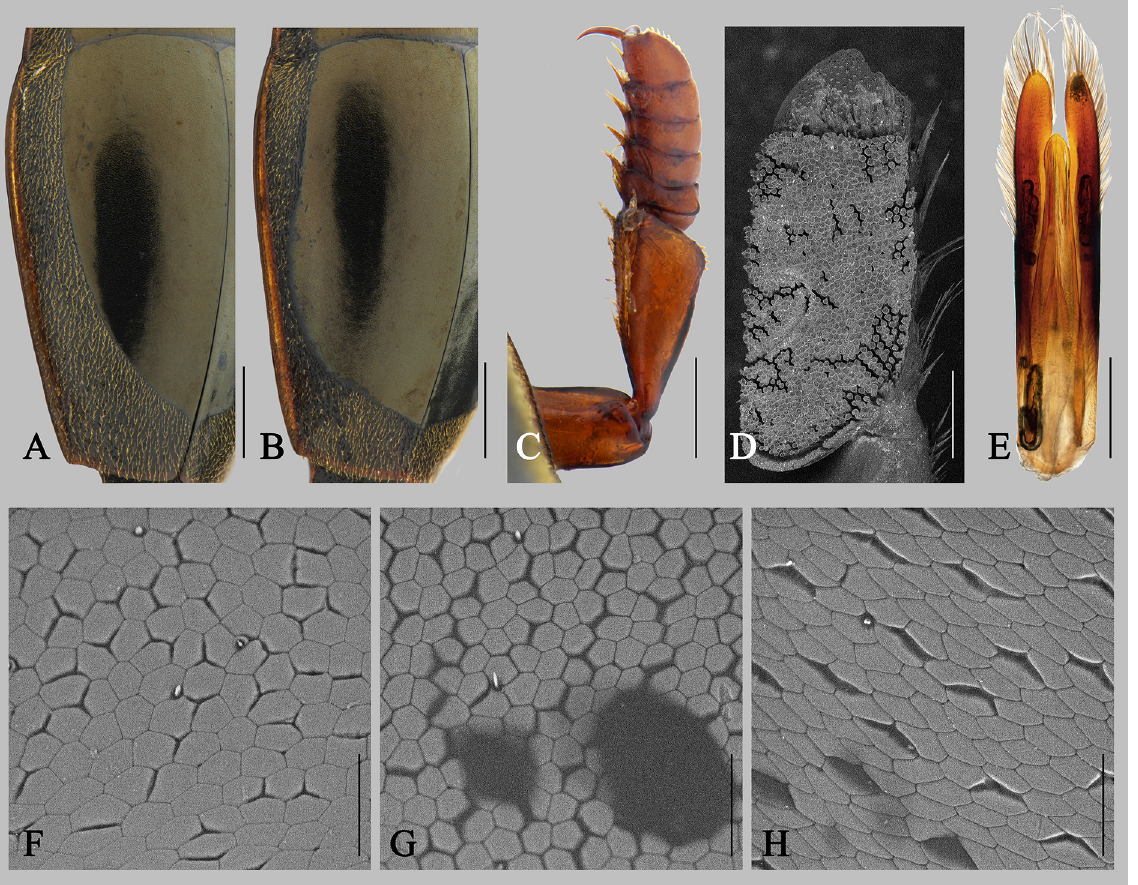
Fig. 5. Patrus shangchuanensis sp. nov. (SYSU). A . ♂, paratype, left elytron. B . ♀, paratype, left elytron. C . ♂, paratype, front leg. D . ♂, paratype, front tarsus. E . ♂, holotype, genitalia. F . ♂, paratype, surface sculpture on head. G . ♂, paratype, surface sculpture on pronotum. H . ♂, paratype, surface sculpture on elytra. Scale bars: A–B = 1 mm; C, E = 0.5 mm; D = 200 μm; F–H = 30